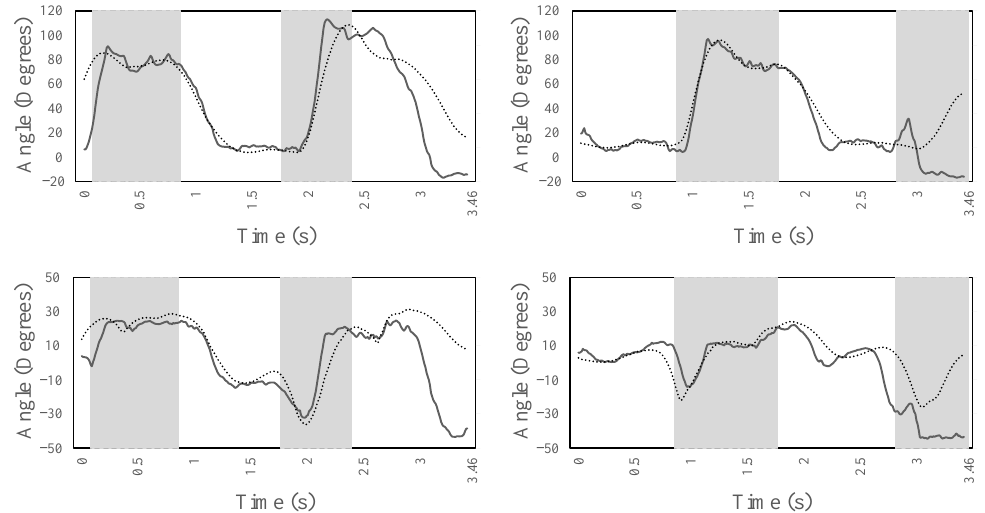
Figure 6. The kinematics of the left/right knee ( top ) and left/right ankle joint ( bottom ) during stair ascent for the entire simulation time. The areas marked in gray show the period where the leg is not in contact with the ground. The dotted lines are the experimental data; the continuous lines are the forward dynamic simulation